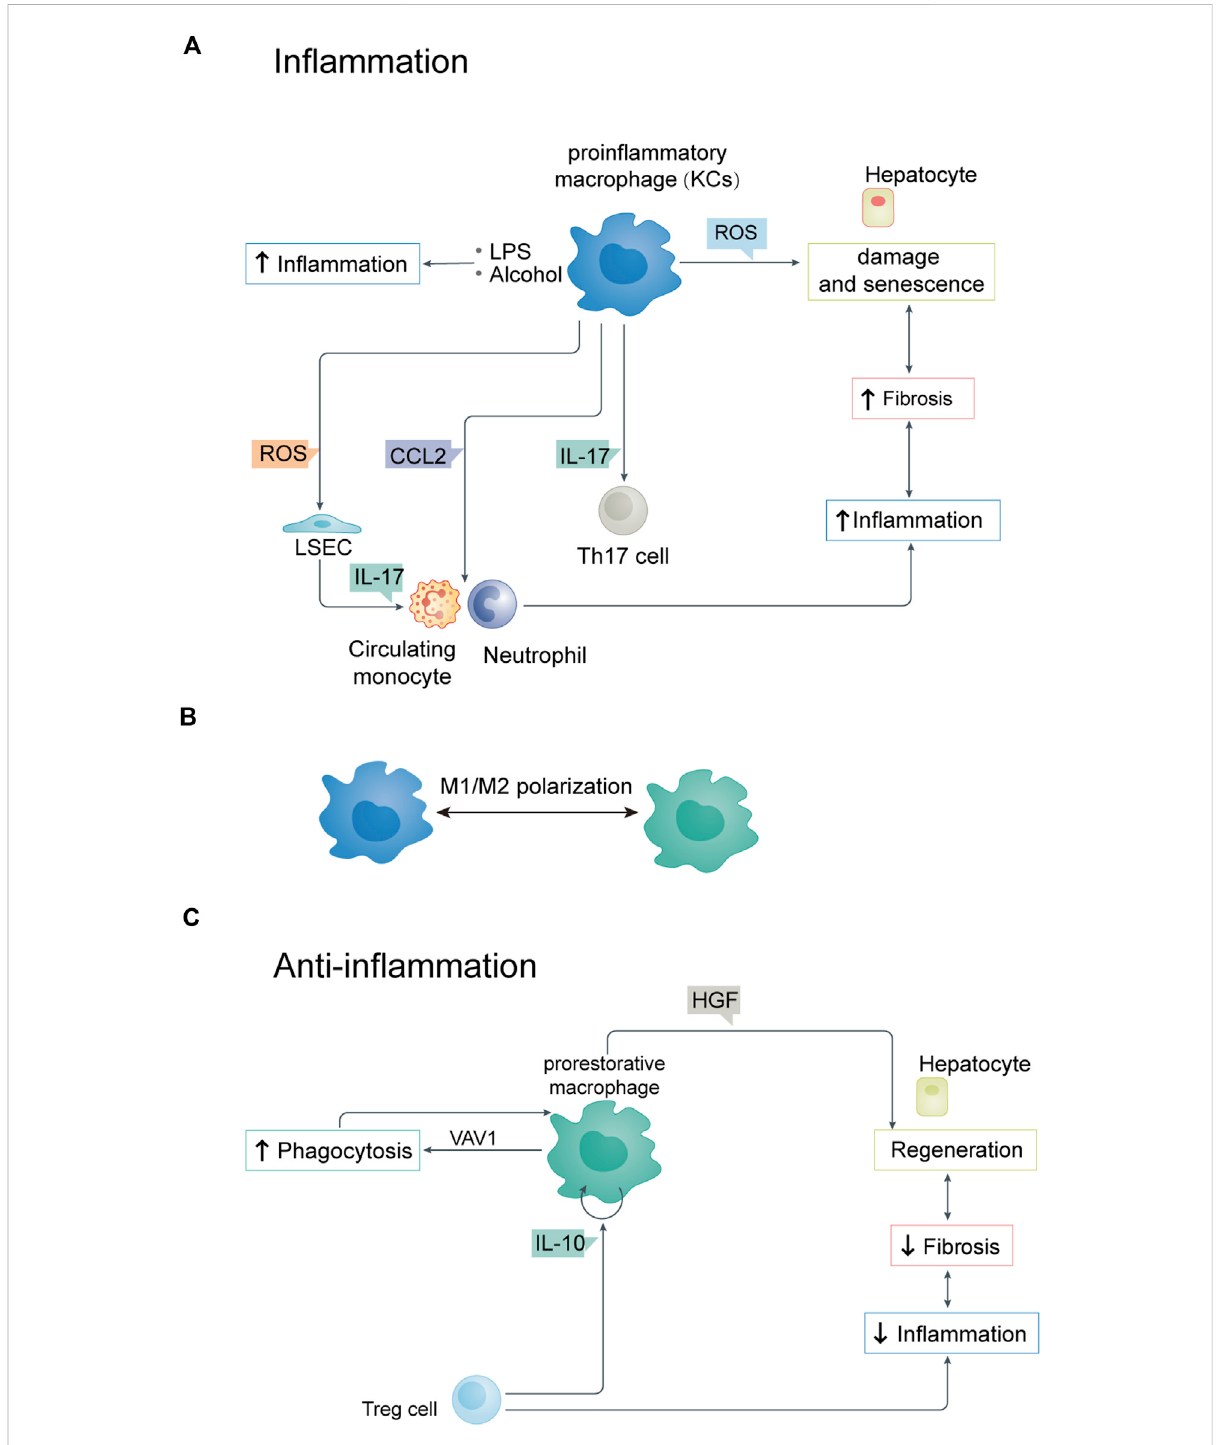
FIGURE 2 (A) Relationship between parenchymal and non-parenchymal cells during in fl ammation. (B) M1/M2 polarization of KCs. (C) Relationship between parenchymal and non-parenchymal cells during anti-in fl ammation. LSEC, liver sinusoidal endothelial